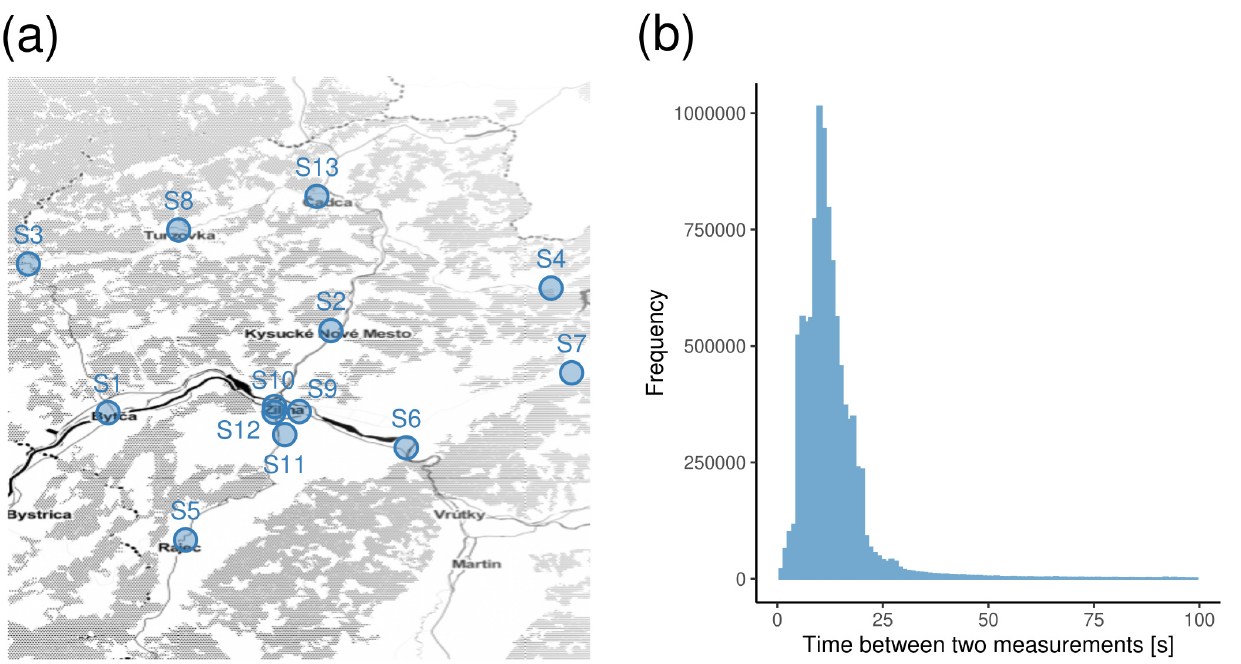
Figure 1. ( a ) The geographical area of the Žilina region with the marked positions showing ambulance stations where the crews of the observed emergency vehicles are based. Four ambulance stations, S9–S12 are located within the city of Žilina, and ambulance stations S1–S8 and S13 are distributed in the neighbouring small towns and villages. ( b ) The frequency of measurements of the car floating